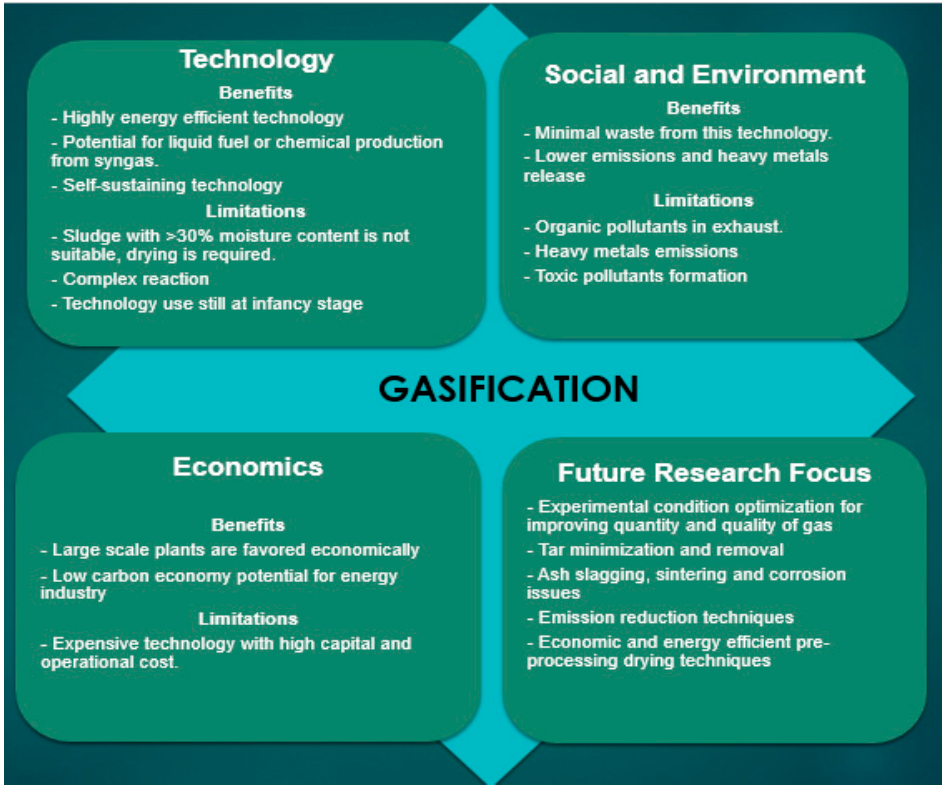
Figure 10. Technological, Socio-environmental and Economic Assessment of Gasification for Sludge Figure Processing.